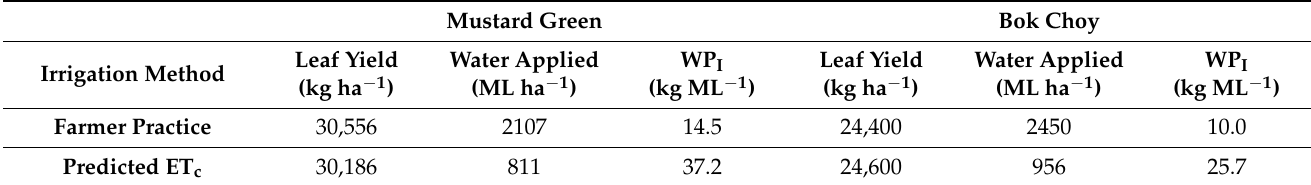
Table 6. Yield, water applied, and irrigation water productivity (WP I ) for leafy vegetable crops in Kampot and Siem Reap Provinces, Cambodia, 2019, irrigated using farmer practice (twice per day) and with guidelines based on predicted ET c (once per day).